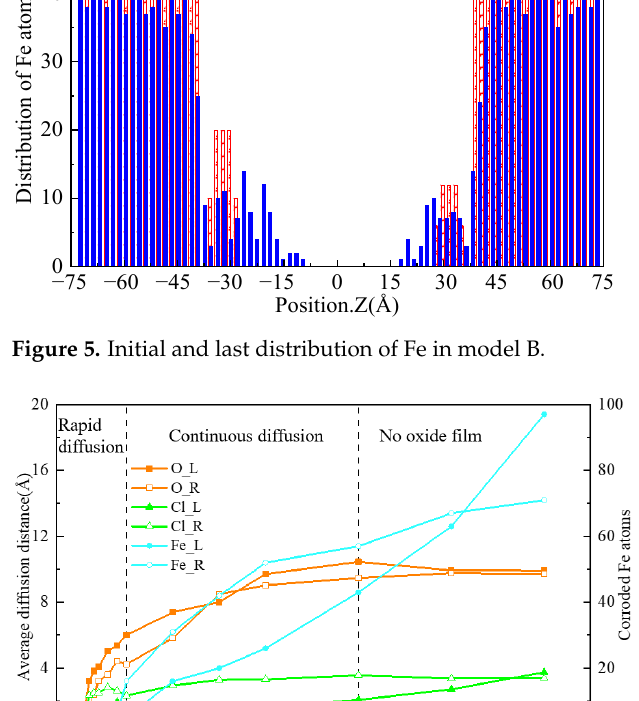
means the left side with a complete oxide film, and R means the right side with an incomplete one.